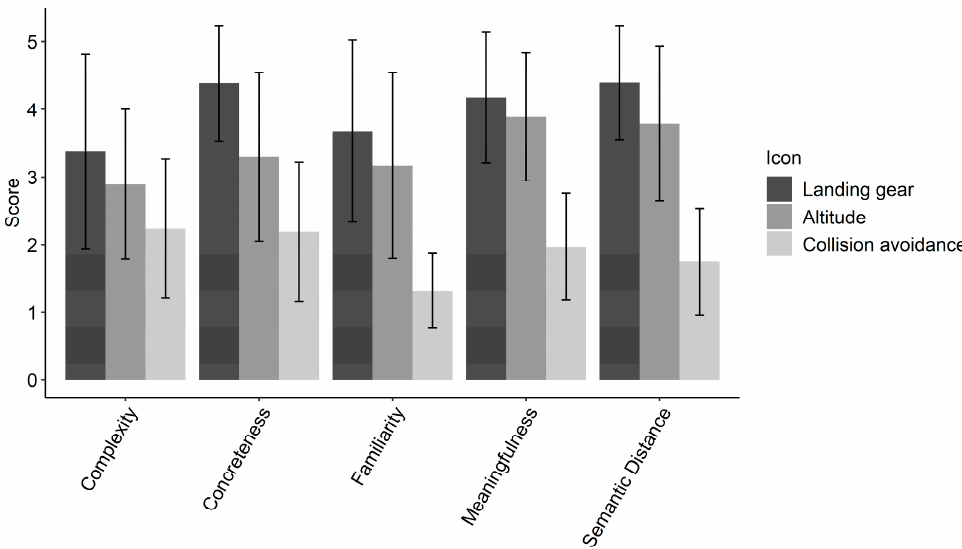
Figure 6. Means and standard deviations for the icon characteristic ratings of the icons representing landing gear ( H = 0.0), altitude ( H = 1.3) and collision avoidance ( H = 3.3).